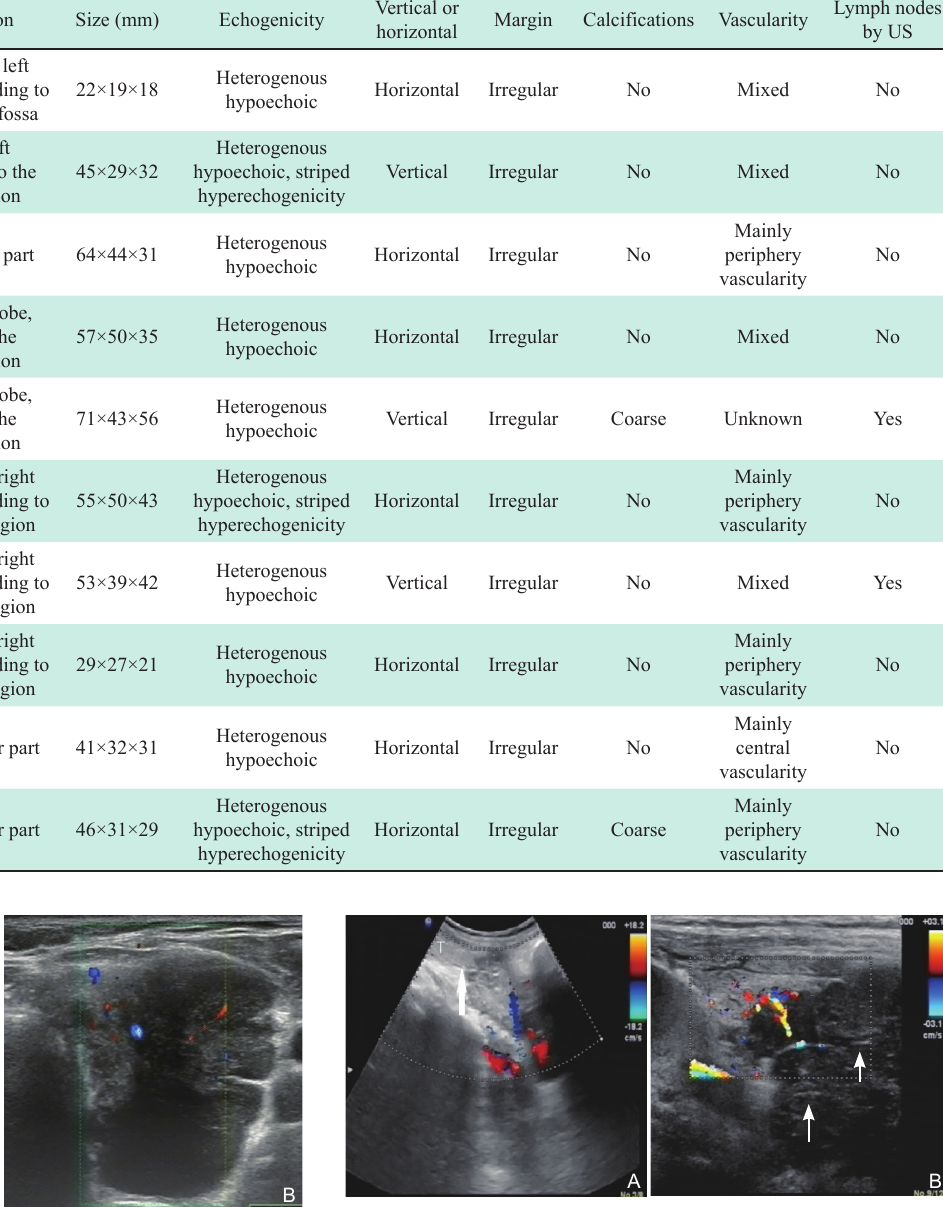
Figure 1 (A) The thyroid nodule of a 71-year-old female, shown as patient No. 2 in the Table 1. The nodule within the left lobe of the thyroid in transverse section was heterogeneously hypoechoic with striped hyper- echogenicity, an irregular margin, and a taller-than-wide shape (vertical). The arrow shows the striped hyper-echogenicity within the nodule; (B) Mixed blood flow signal was observed within the nodule in